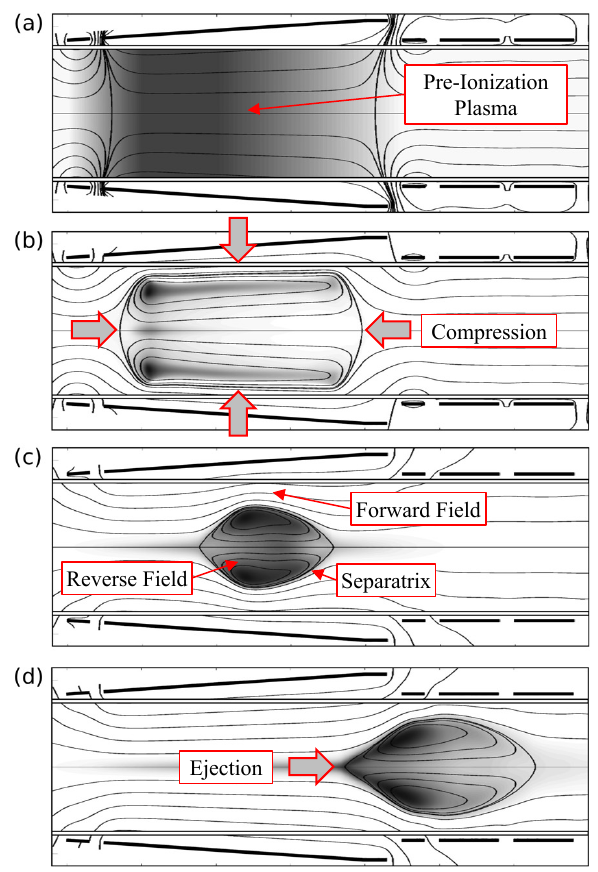
Figure 8. Schematic showing field-reversed theta pinch formation for closed magnetic flux thrusters: h -pinch matching the MSX geometry using typical gas fill and magnetic ( a ) preionization plasma is introduced into a background magnetic field; ( b ) a strong pulse of current conditions. Magnets are indicated by heavy black lines, the quartz discharge generates a time-dependent magnetic field with polarity opposing the initial background magnetic tube by a double black line, magnetic field contours by thin black lines, and plasma density is represented in grey-scale (auto-scaled for each frame). field that compresses the plasma both radially and axially; ( c ) a closed magnetic field structure confines the plasma within a separatrix that divides the forward and reverse fields; and ( d ) magnetic field gradients in the axial direction accelerate and eject the resulting plasmoid (Reproduced/modified from [29]; with the permission of AIP